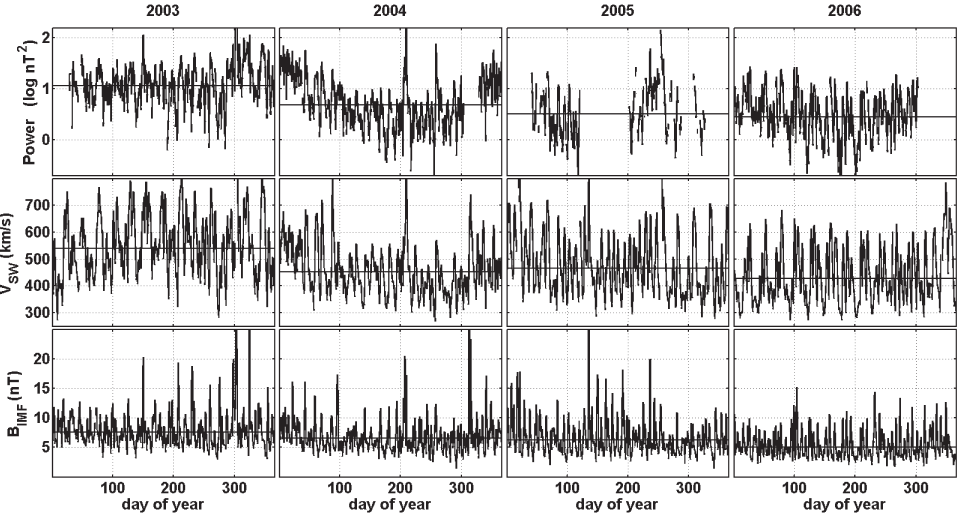
Fig. 3. One-day running averages of Pc3-5 power of the horizontal component at TNB (2003, 2004, 2006) and DMC (2005) stations, SW speed and IMF